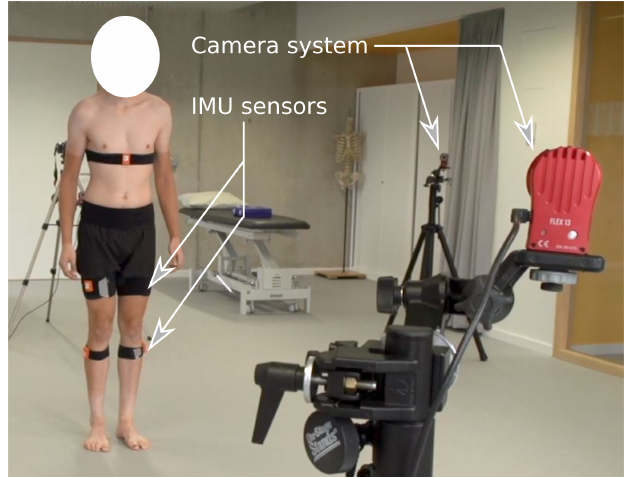
Figure 7. Experimental setup with visual markers for the camera system for comparison and IMU sensors for motion estimation with the proposed